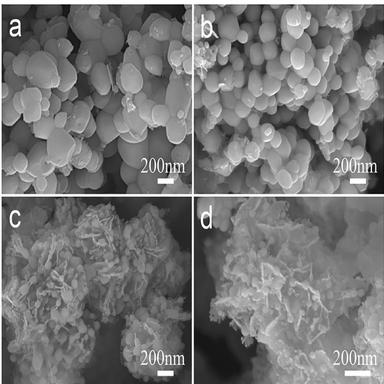
SEM images of Ni–Co selenide samples with different Ni to Co ratios: (a) NiSe2, (b) Ni0.83Co0.17Se2, (c) Ni0.5Co0.5Se2 and (d) Ni0.33Co0.67Se2.